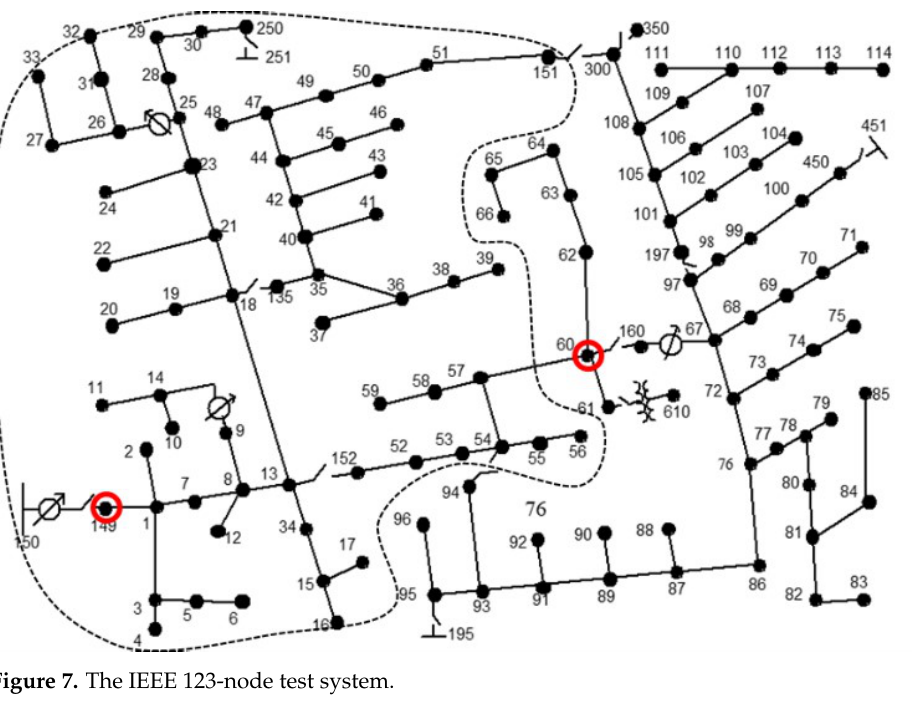
Figure 7. The IEEE 123-node test system.